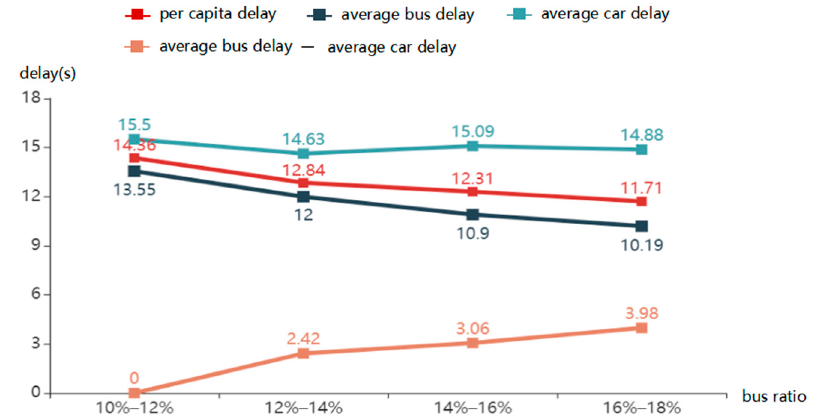
Figure 17. Optimization results with different bus ratios.